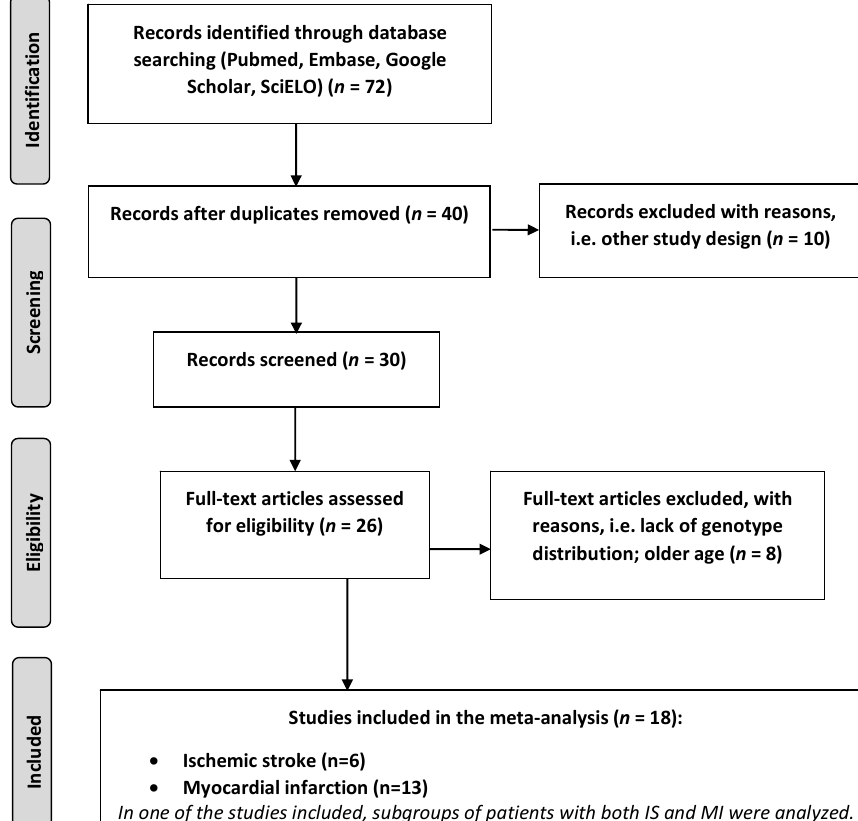
Figure 1. Flow chart presenting the process of searching for eligible articles.